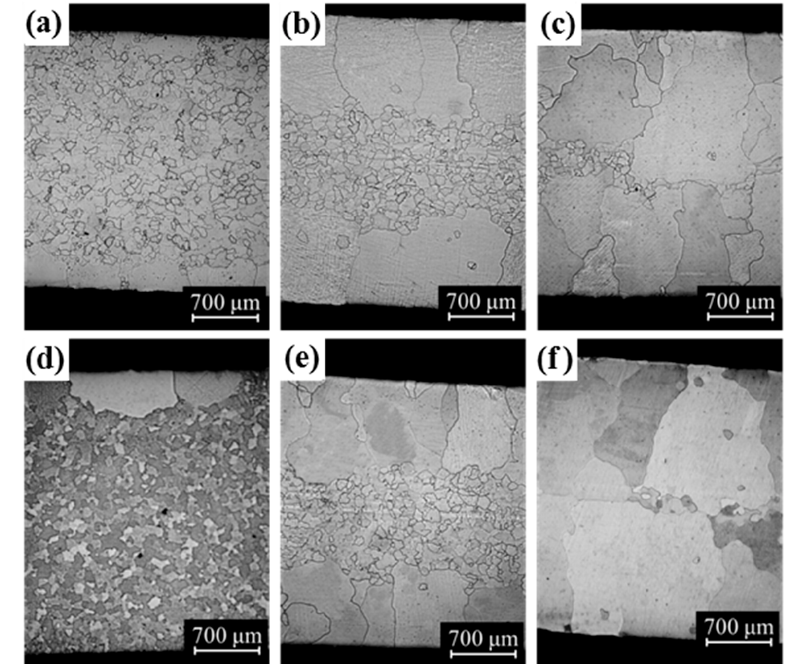
Figure 4. ( a ) Time to 710 °C: 7.6 h, soaking time 72 h, ( b ) time to 740 °C: 7.9 h, soaking time 42 h, ( c ) time to 850 °C: 9.1 h, soaking time 0.25 h, ( d ) time to 960 °C: 10.4 h, soaking time 0.25 h and (e) time to 1030 °C: 12 h, soaking time 0.25 h. Micrographs were taken through the thickness of the strips.